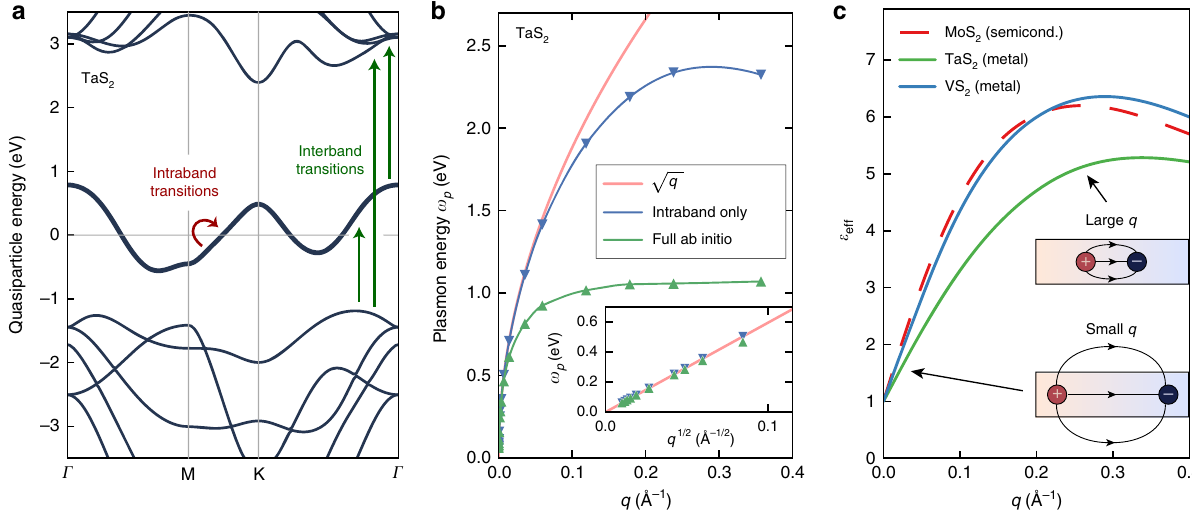
Fig. 1 Plasmon dispersion relation of an atomically thin quasi-2D crystalline metal. a Calculated GW quasiparticle band structure of a prototypical quasi- 2D metal, monolayer TaS 2 . The arrows highlight the intraband and interband electronic transitions that contribute to a plasmon excitation. The Fermi energy is set at zero. b Calculations of the plasmon dispersion relation of monolayer TaS 2 . The green curve is the result of the full ab initio calculation, which displays a fl attening of the plasmon dispersion relation; the blue curve corresponds to the result of a calculation including only the intraband ffiffiffi p q transitions, which displays a dispersion relation much closer to ~ (red curve). The inset shows the small- q behavior of the plasmon dispersion relation, ffiffiffi p q where both calculations follow a dependence. c Effective 2D dielectric function ε eff ( q ) for two point charges located at the innermost portion of three different quasi-2D materials. Since ε eff ( q ) does not include intraband (but only interband) transitions, its behavior is similar to quasi-2D semiconductors. For very small wavevectors, there is no screening ( ε eff ( q = 0 ) = 1)) since very long wavelength perturbations correspond to charges being so far apart that they only experience the screening of vacuum. For increasing wavevector q , the charges get closer, so more of the fi eld lines connecting them are con fi ned to the interior of the quasi-2D material. ε eff ( q ) increases linearly with q until it reaches near a maximum, and subsequently decreases with increasing q after the maximum due to the intrinsic inability of the medium to screen very short-wavelength